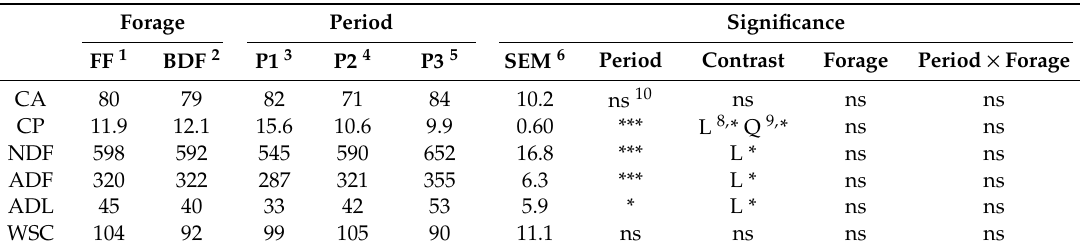
Table 3. Crude ash (CA) (g / kg dry matter (DM)), crude protein (CP) (g / kg DM), neutral detergent